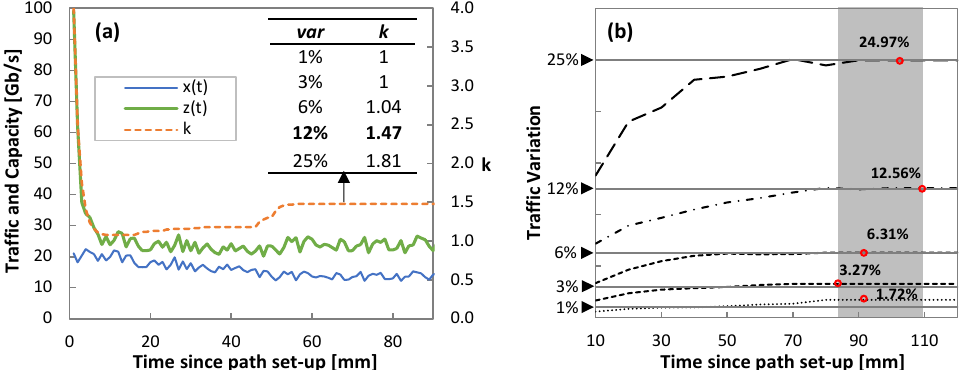
Figure 13. Phase I: Self-tuned threshold ( a ) and traffic variance analysis ( b ). Parallel to the threshold-based operation, traffic variance analysis (Algorithm 2) is computed traffic variation as a function of time for all traffic configurations. Round markers highlight when the derivative of traffic variance reached a small eps = 0.01 and labels show the final computed variance value. The low error between computed and true variances is noticeable. Such estimation is achieved within two hours in all the